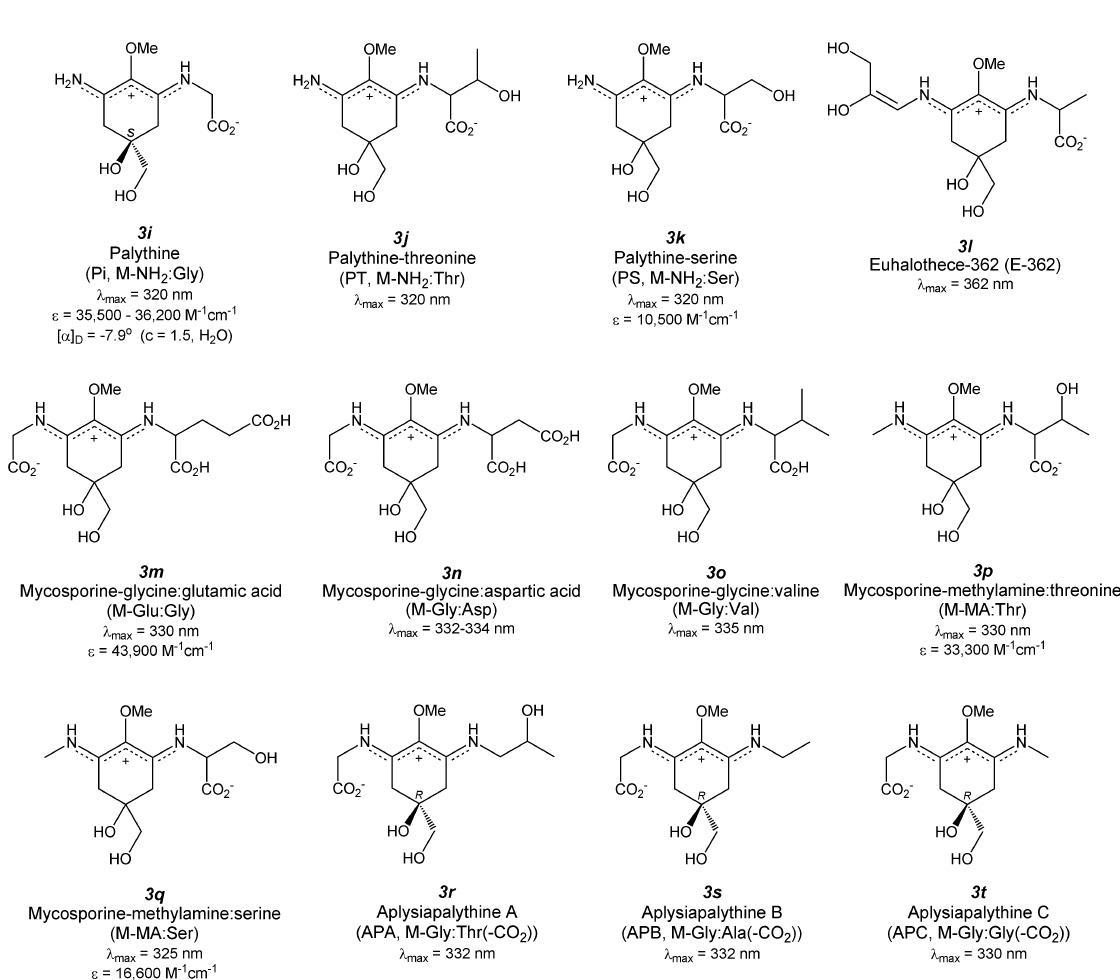
Figure 4. Chemical structure and spectroscopic properties of aminocyclohexene imine-type MAAs. Abbreviation is in